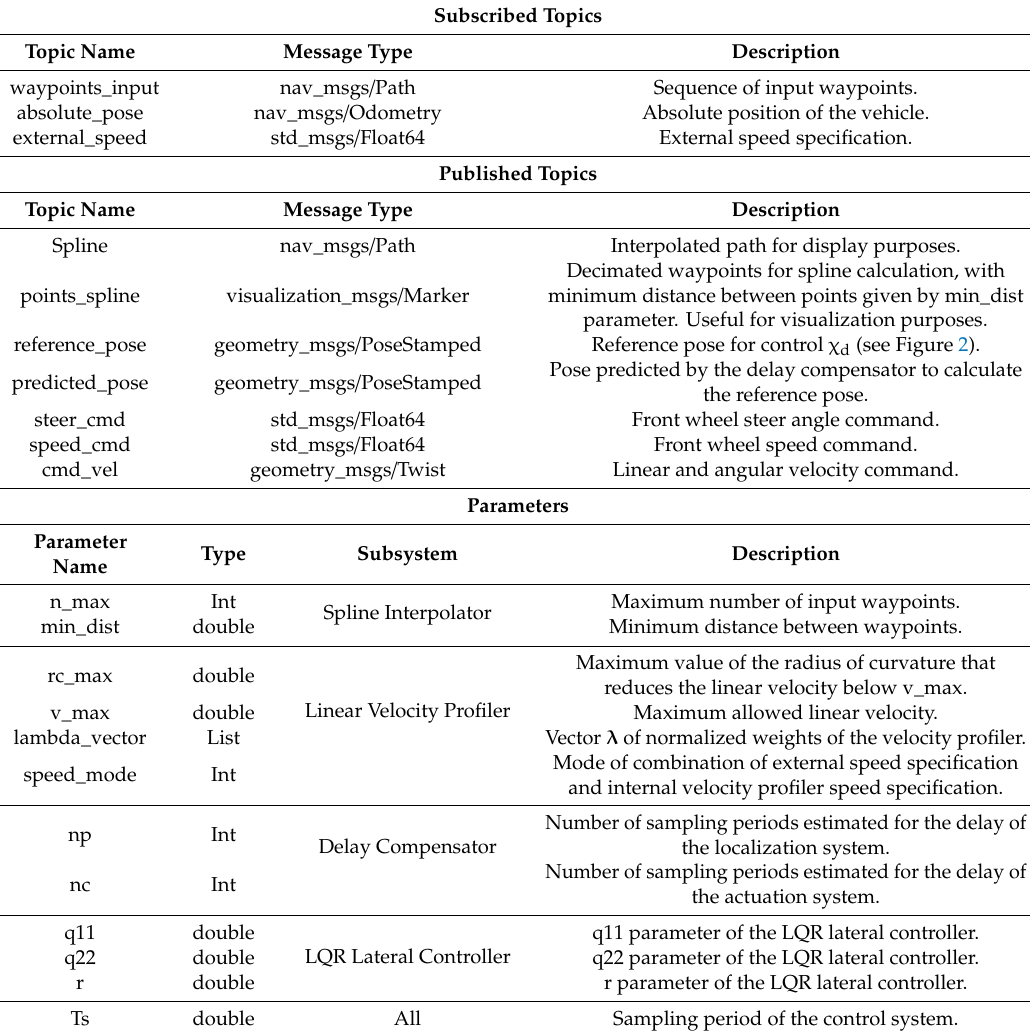
Table 1. List of subscribed topics, published topics and parameters for the “controller_node” node of the “Waypoint_Tracking_Controller”